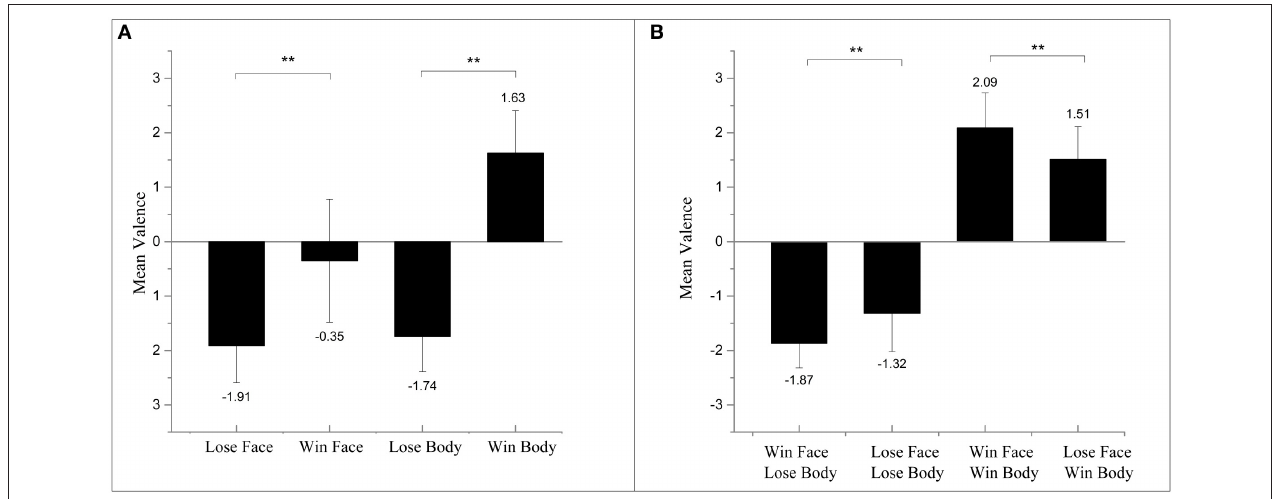
FIGURE 2 | (A) Results of mean valence ratings for images of isolated face and isolated body. (B) Results of mean valence ratings for images of face and body compounds. ** p < 0.01.